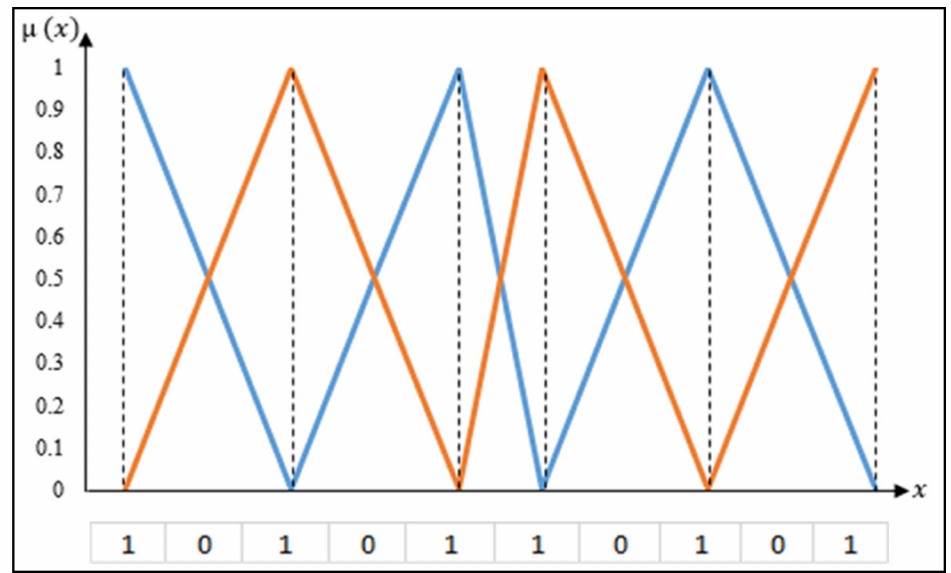
Figure 10. Membership function of fuzzy